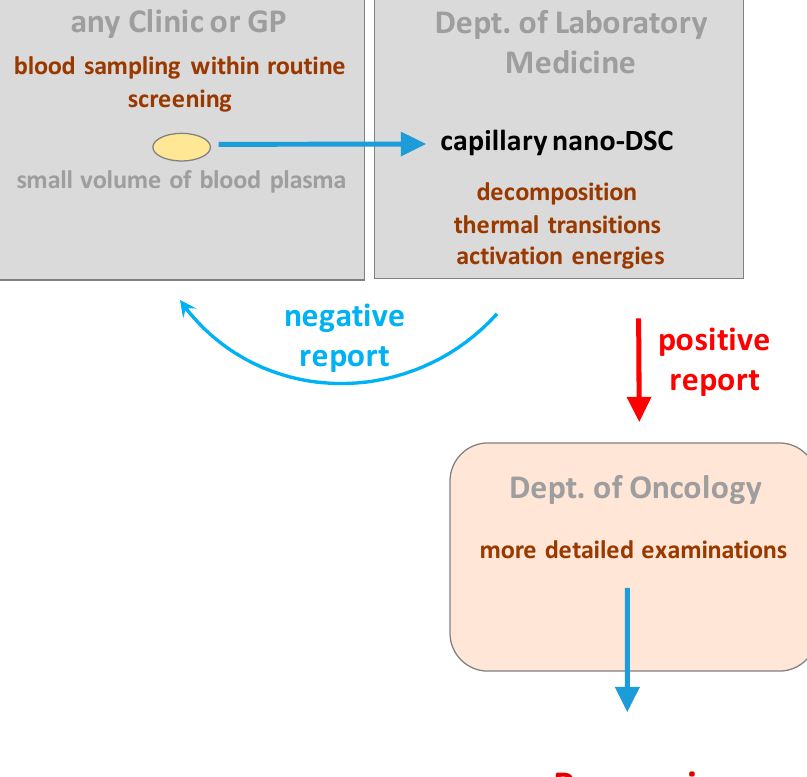
Figure 5. Summary figure to explain how DSC may be particularly relevant in clinical diagnosis.